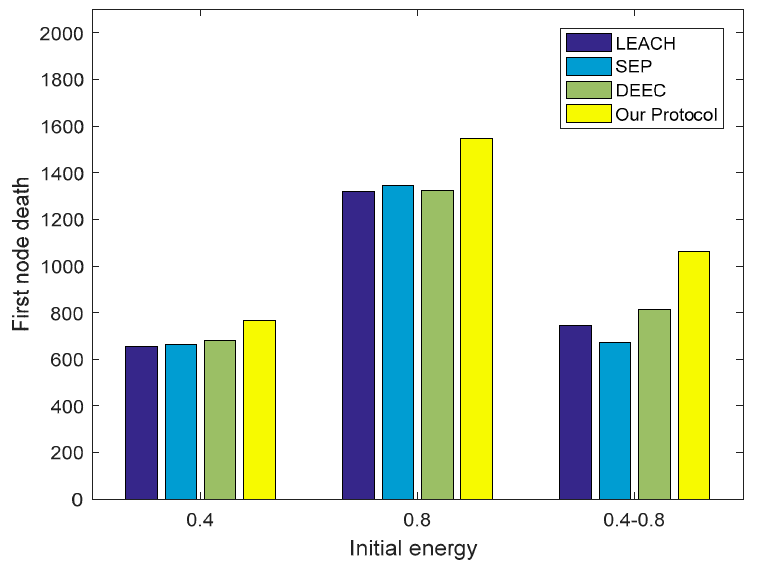
Figure 13. The round of the first node’s death. LEACH: Low-Energy Adaptive Cluster Hierarchical; SEP: Stable Election Protocol; DEEC: Distributed Energy-Efficient Clustering.